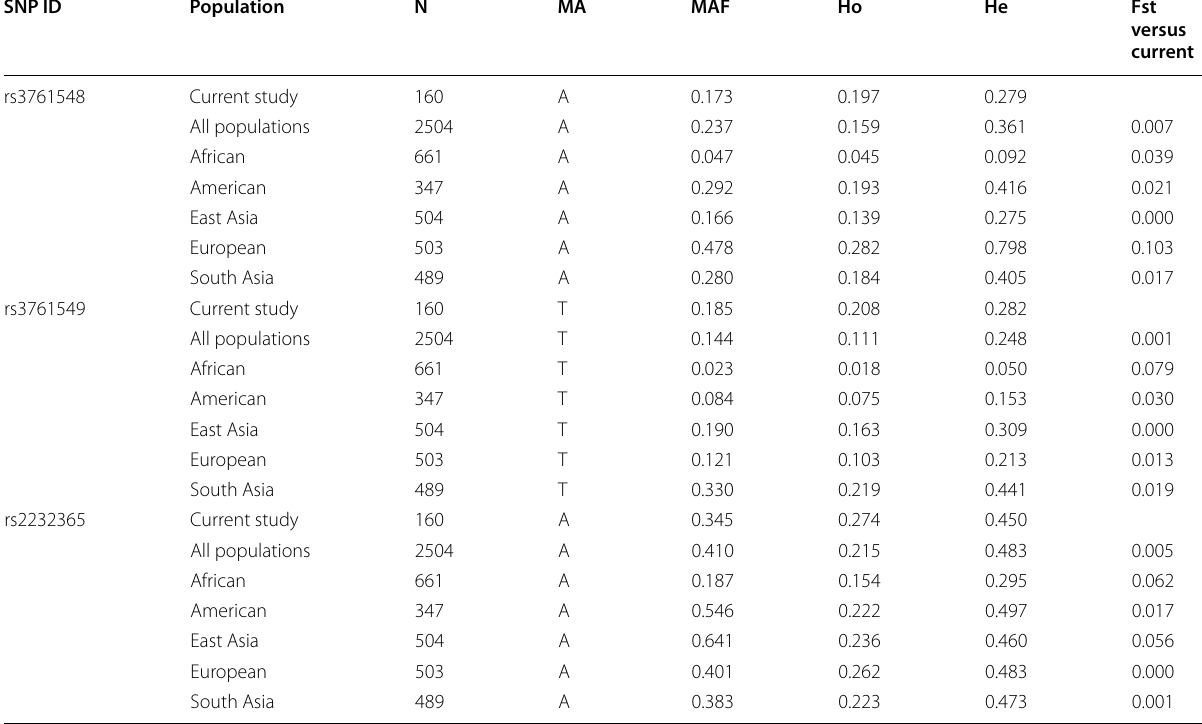
Table 6 Comparison of the studied SNPs genetic variability between healthy control subjects in the current study and main ethnic groups in the 1000 genome